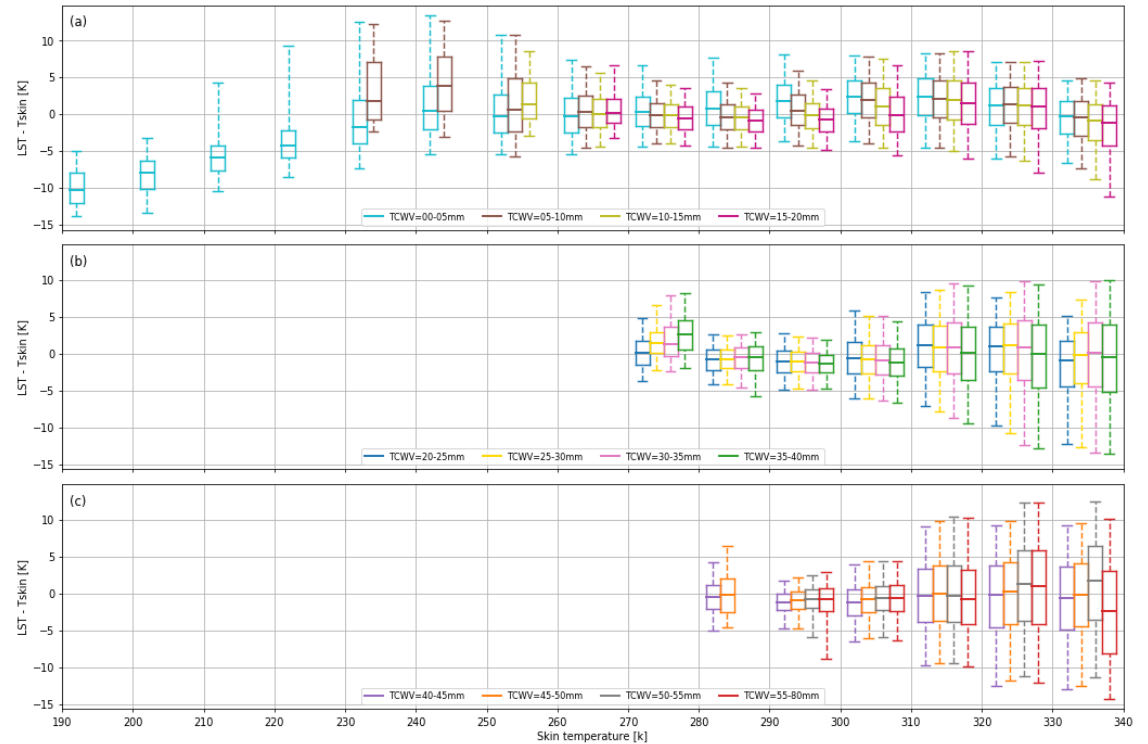
Figure 6. Distribution of differences between satellite LST and ERA5 Tskin (K) for each TCWV class (( a ) 0–5, 5–10, 10–15 and 15–20 mm; ( b ) 20–25, 25–30, 30–35 and 35–40 mm; ( c ) 40–45, 45–50, 50–55 and 55–80 mm). The bold line represents the median, the box represents the 25th to 75th percentiles, and the whiskers represent the 5th and 95th percentiles.